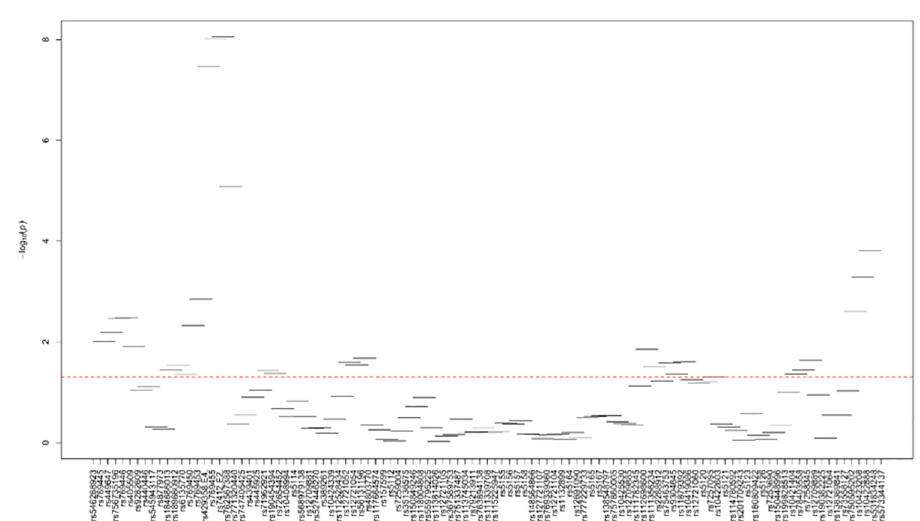
Fig 9. Plots of haplotype-based association analysis results for LDL-C in African blacks. Horizontal lines represent the 4-SNP windows. X-axis shows the SNPs genotyped in the regions based on the order of APOE , APOC1 , HCR1 , HCR2 , APOC4 and APOC2 while the Y-axis shows the–log (global p-value) with red line representing the p-value threshold (P = 0.05).